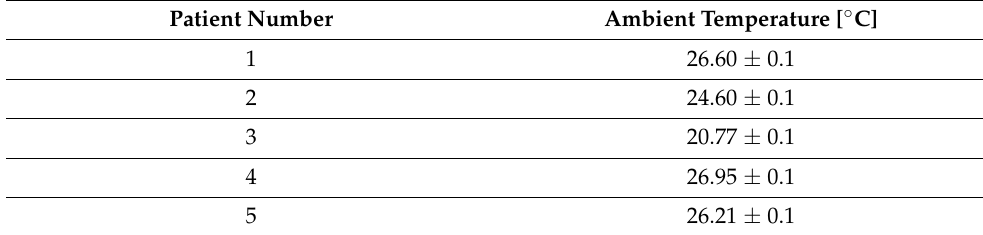
Table 1. Experiment ambient temperature.